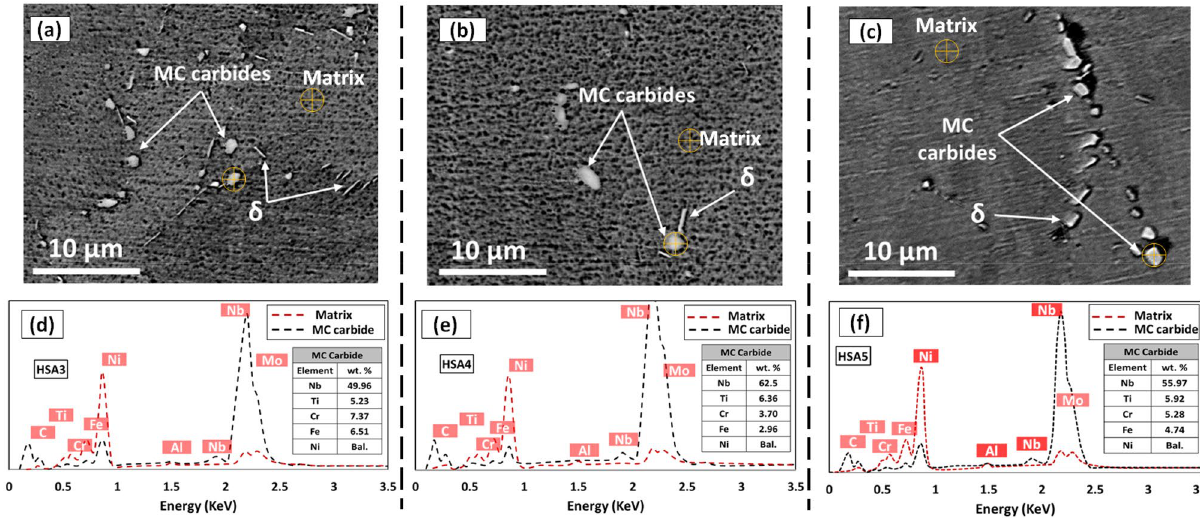
Figure 8. ( a – c ) SEM micrograph of LPBF IN718 in heat treatment conditions of: HSA3, HSA4 and HSA5, respectively, and ( d – f ) the corresponding EDS spectrum analysis diagram of the spots indicated in SEM micrographs, illustrating the concentration difference of the Nb between the γ-matrix and MC